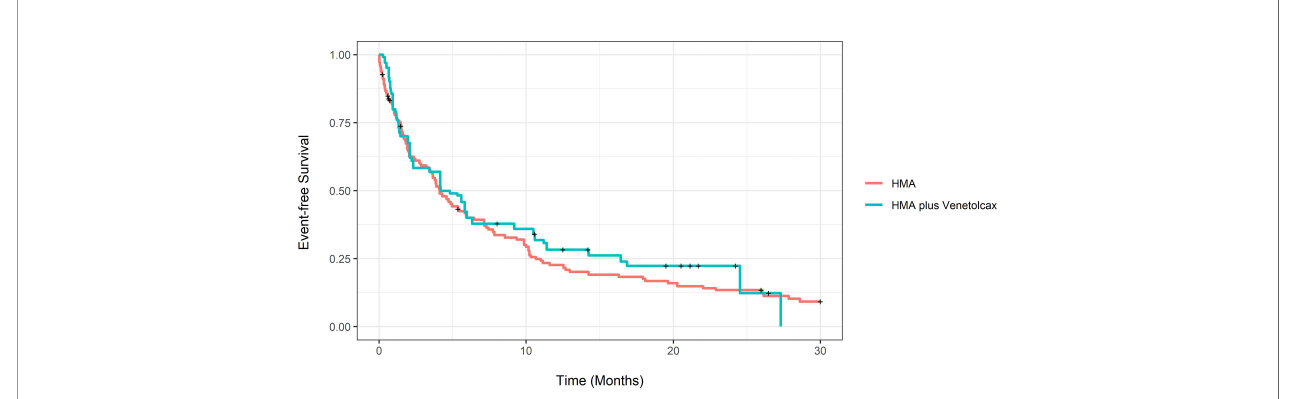
unadjusted m-OS for patients treated with AZA and DEC was 8.0 (CI: 4.73-22.9) and 8.57 (CI: 5.83-10.6) months (P=0.6). Adjusted OS difference at years 1-4 for patients with AZA vs. DEC was not signi fi cantly different ( eTable 10 ). Adjusted- relative mortality for patients treated with DEC compared to AZA was also not signi fi cantly different (HR: 1.25, CI: 0.77-2.06, P= 0.36). eFigure 9 demonstrates adjusted OS. The adjusted m- EFS for patients treated with AZA vs. DEC was 3.8 (CI: 3.5-9.87) compared to 5.47 (CI: 2.77-7.83) months (P=0.63) ( eFigure 10 ). Adjusted EFS at years 1-4 for patients treated with AZA vs. DEC was not different ( eTable 11 ).The adjusted-relative mortality or relapse rate for patients treated DEC compared to AZA was not different (HR: 0.8, CI: 0.52-1.24, P= 0.32). The unadjusted and adjusted 30-day TRM in AZA compared to DEC was 14.3% vs. 17.9% (P=0.84) and 12.5% vs. 15.1% (P=0.66), respectively. The unadjusted and adjusted 60-day TRM in AZA compared to DEC was 28.6% vs. 22.6% (P=0.65) and 20.5% vs. 19.3% (P=0.87), respectively.